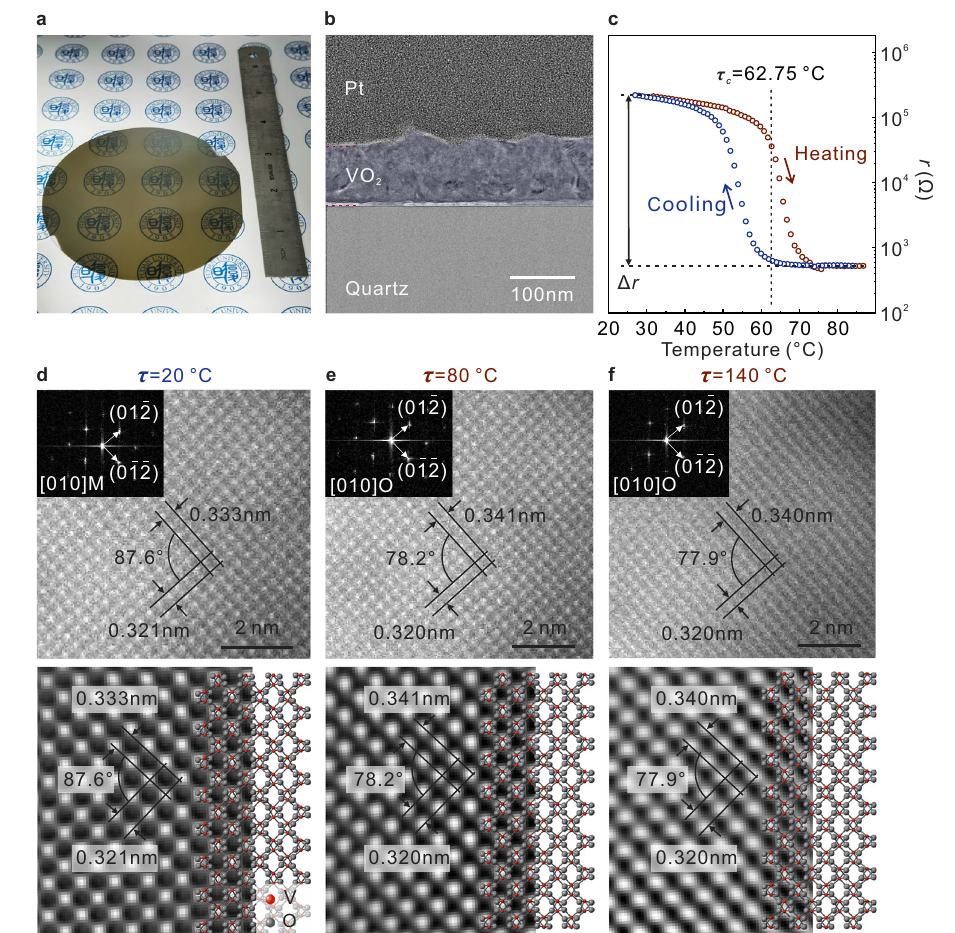
Fig. 2 | Characterization of VO 2 NM lattice structure. a The VO 2 NM grown on 4-inchquartz glass. b Transmissionelectron microscopy(TEM) image of the cross- section of VO 2 NM. c Temperature-dependent resistance ( r ) of VO 2 NM. 4 r corre- sponds to the change of resistance. d – f In situ scanning transmission electron